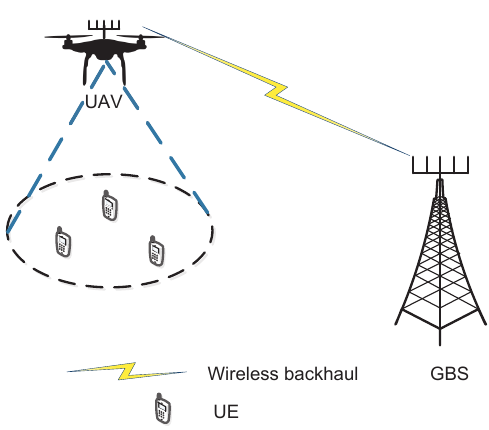
Figure 1. System architecture of a UAV-assisted wireless communication